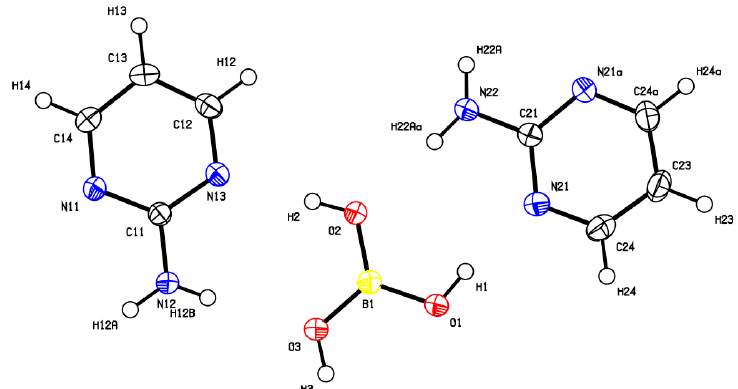
Table 1. Crystal data and structure refinement details of the studied cocrystals.